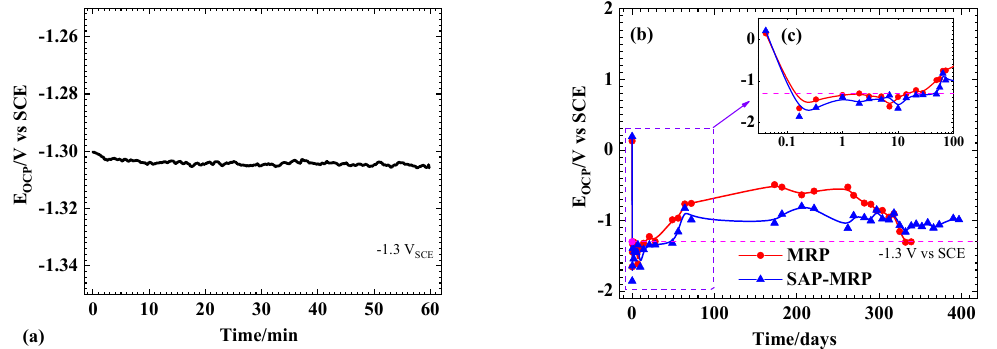
Figure 1. The variations of the open circuit potentials for AZ91D alloy ( a ) and Mg-rich primer (MRP) and SAP-MRP samples ( b ) with immersion time in the simulated acid rain solution; ( c ) partial enlargement of the MRP and SAP-MRP samples during the immersion time from 1 h to 100 days.